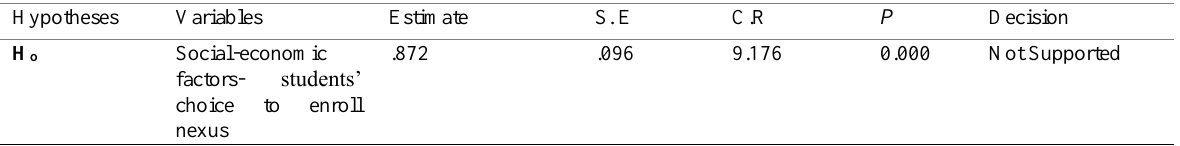
Table 7 : Summary of the Hypothesis